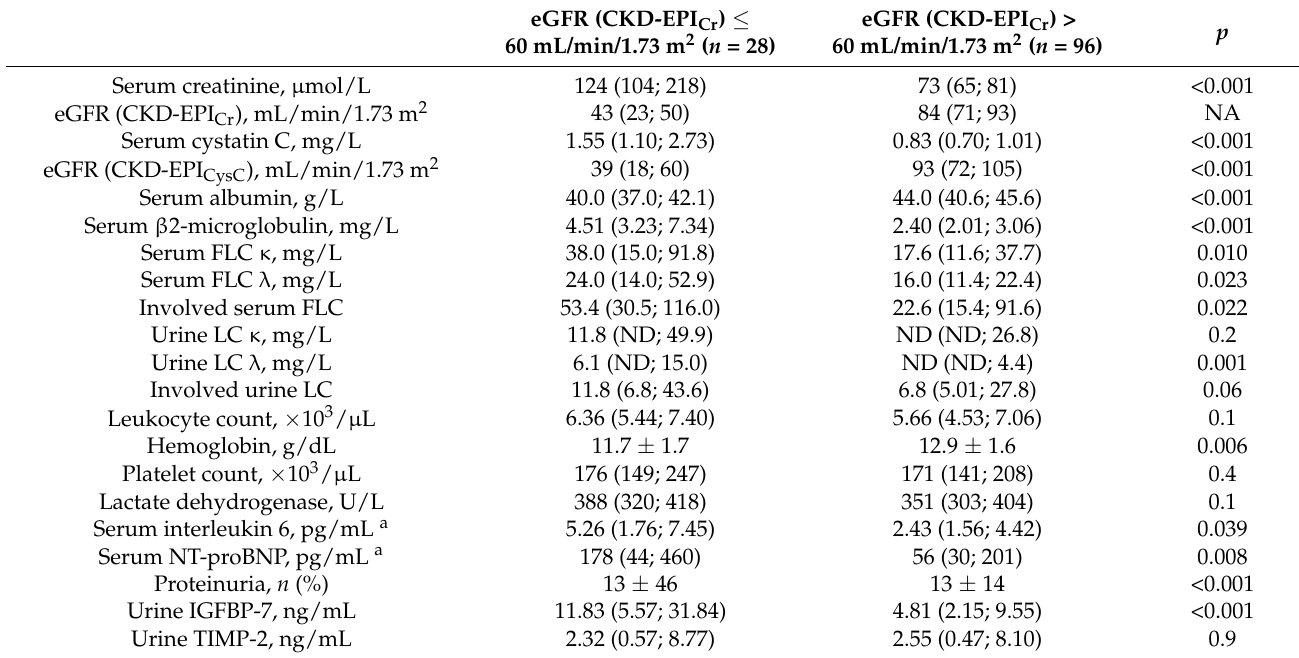
Table 2. The results of the laboratory tests of the studied patients with MM. Data are shown as median (IQR) or mean ± standard